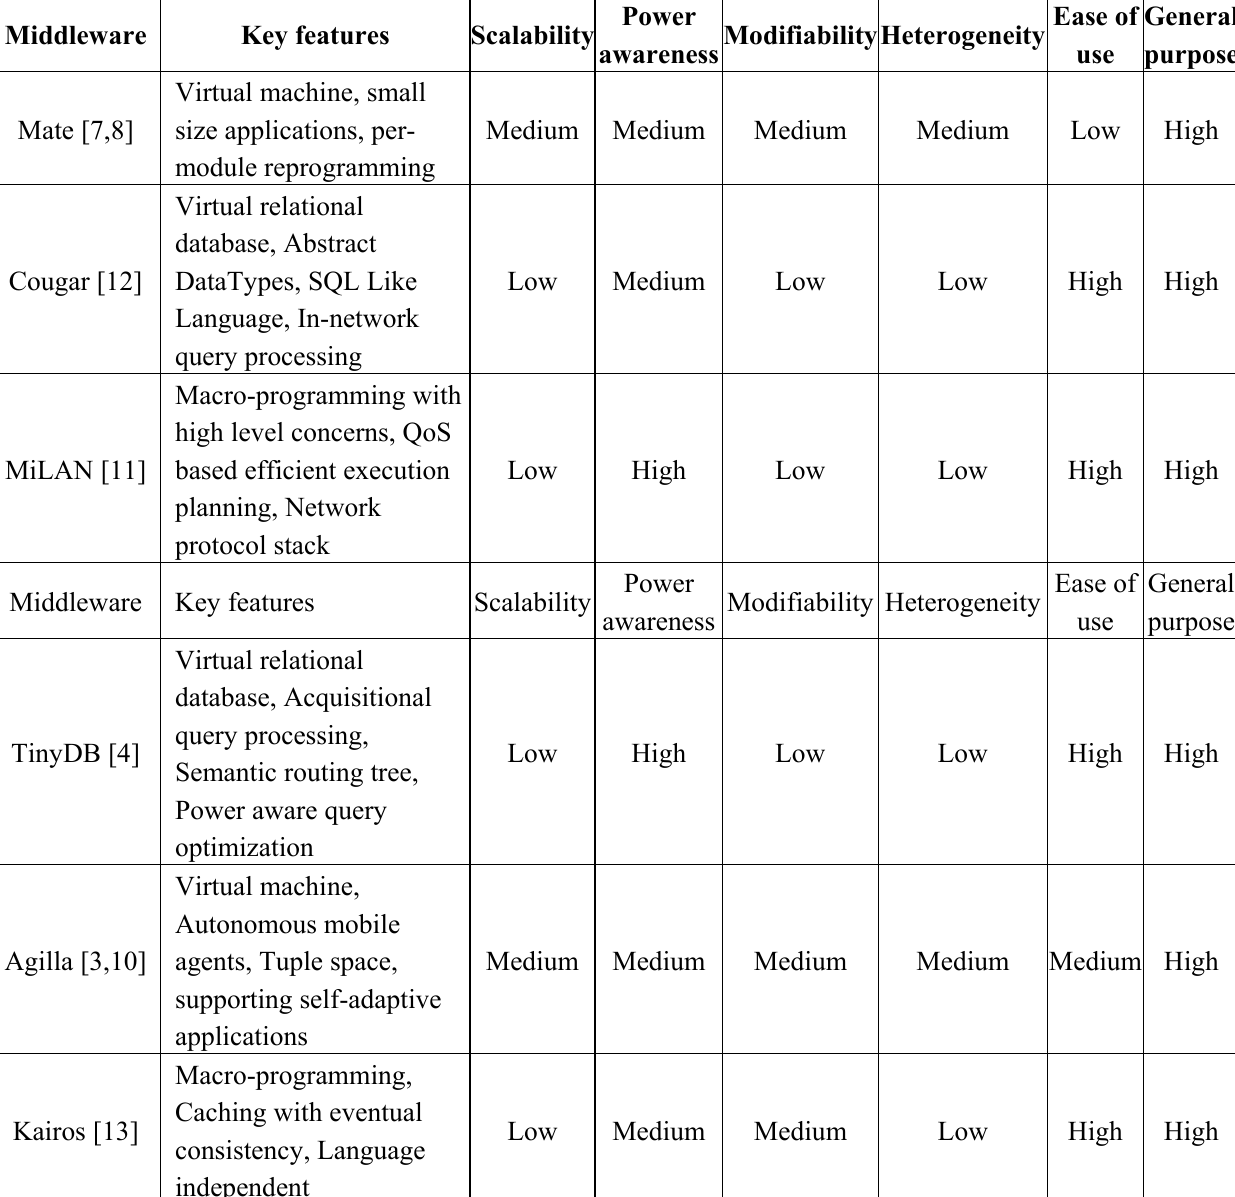
Table 1. Comparing SOMM with other